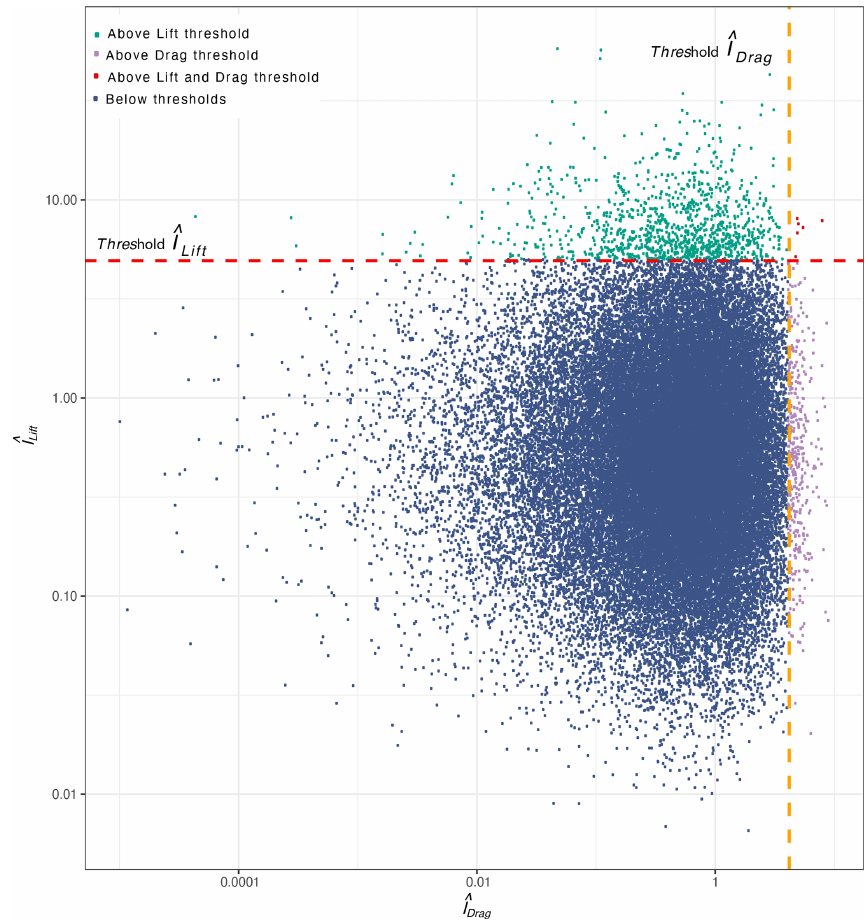
Figure 7. Bootstrap normalised impulse sampling (lift and drag). ˆ I Drag and ˆ I Lift are fitted with a gamma and a lognormal distribution, respectively (Appendix F2). The normalised drag and lift thresholds (red dashed lines) are calculated using the probabilistic drag and lift inertial impulse thresholds presented in Fig. 5, which were divided by the recorded mean inertial drag and lift impulse from the laboratory